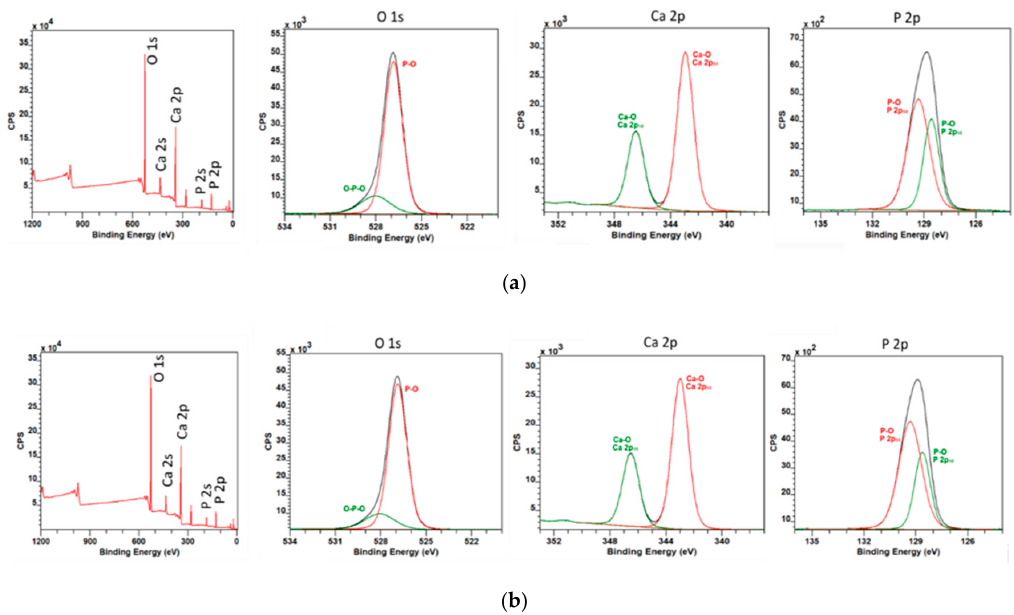
Figure 7. XPS analysis of the hydroxyapatite particles ( a ) before and ( b ) after the plasma treatment.